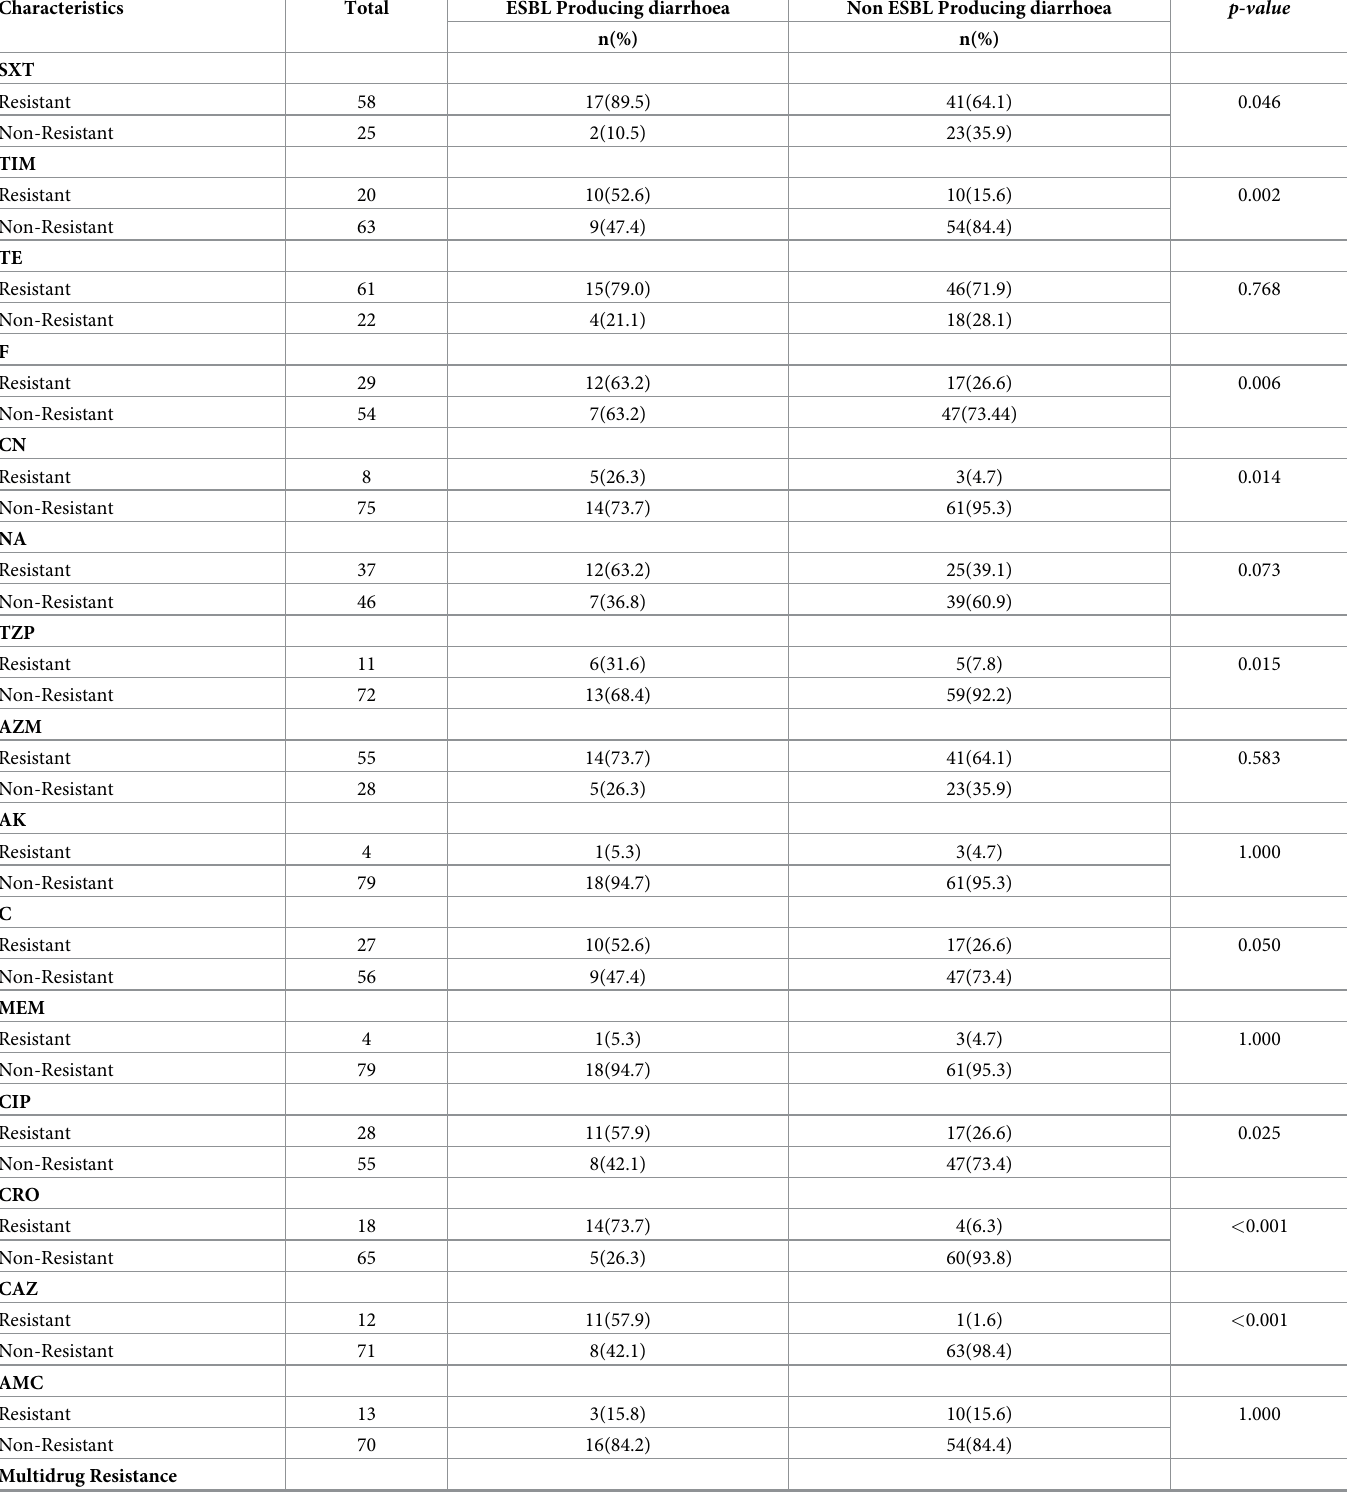
Table 3. Relationship between antibiotic resistance and ESBL/ non ESBL associated diarrhoea.